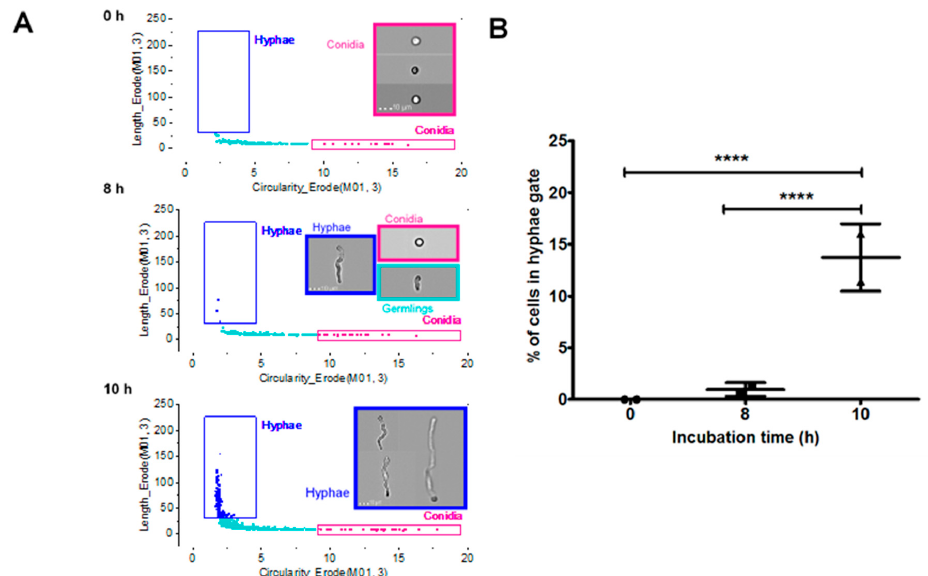
Figure 5 . Initial characterisation of fungal morphologies of A. fumigatus (V130-15) using imaging flow cytometry. ( A ) Discrimination between fungal morphologies using length and circularity features in IDEAS analysis software: conidia, pink box; germlings, cyan box; hyphae, dark blue box. ( B ) The percentage of cells in the hyphae gate shown at the different timepoints. Conidia suspended in RPMI were incubated for 0, 8 or 10 h at 37 °C. Cells were fixed in 4% paraformaldehyde and analysed using imaging flow cytometry. Data was obtained in duplicate, each with triplicate readings; mean values ± SD are shown. **** p < 0.0001 as assessed by two-tailed T test.